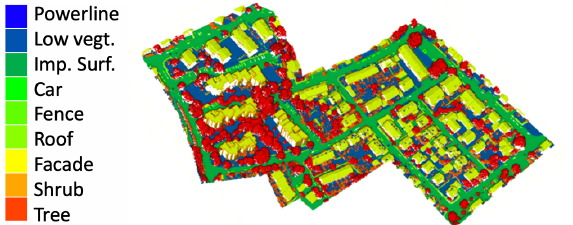
Figure 4. Vaihingen dataset, training data with original classes.